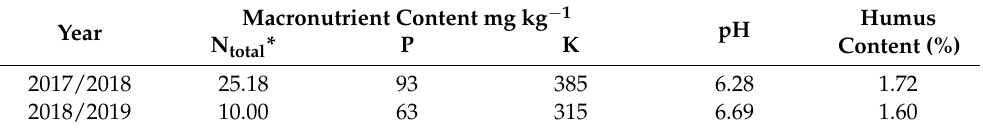
Table 3. Soil properties in experimental